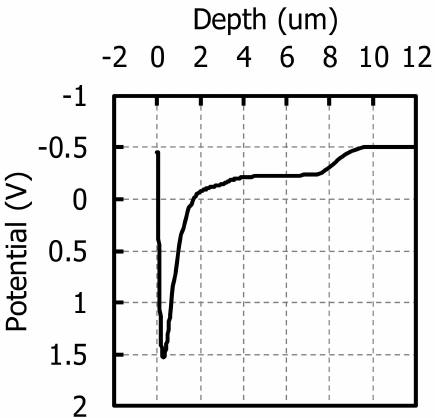
Figure 18. One-dimensional potential profile of the center of the PD.